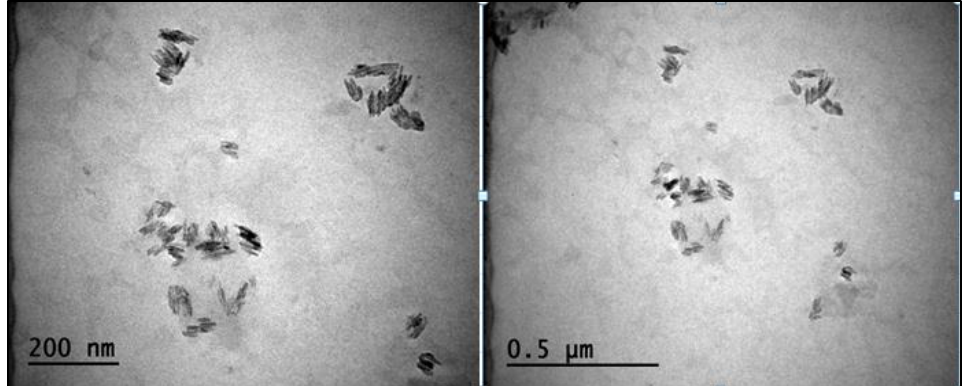
Figure 6. TEM images of CNC from apricot pomace at 200 nm and 0.5 µm size.